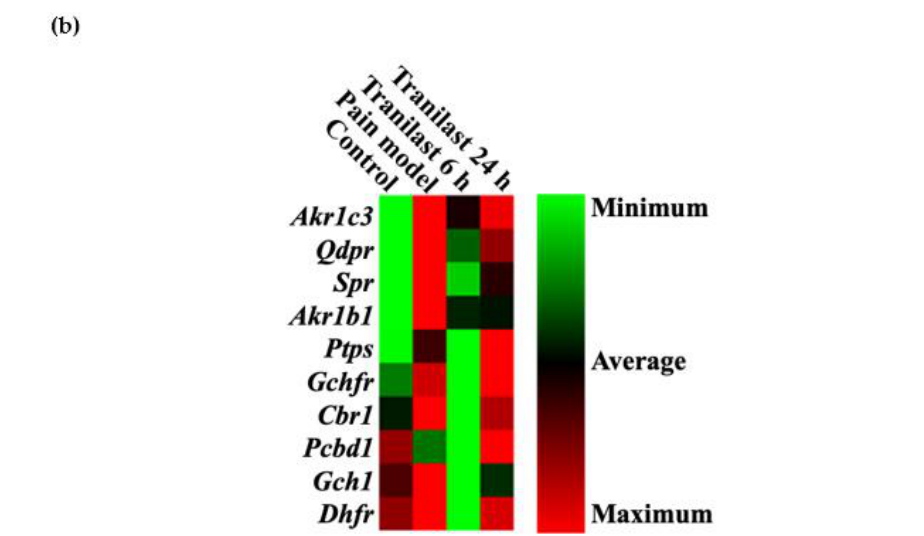
Figure 6. Tetrahydrobiopterin (BH4) synthesis pathway and analysis. ( a ) The three metabolic path- ways involved in BH4 production, the de novo (blue), salvage (yellow), and recycling pathway (green). The synthesis of BH4 begins at the “ de novo ” pathway, starting from guanosine triphosphate (GTP) catalyzed by the following enzymes: GTP cyclohydrolase 1 (GCH1) modulated by the GTP cyclohydrolase 1 feedback regulator (GCHFR), 6-pyruvoyltetrahydropterin synthesis (PTPS), and sepiapterin reductase (SPR). Additionally, the final step can be influenced by two enzymes: aldoketo reductase (AR) and carbonyl reductase (CR). Alternatively, the “salvage pathway” involves SPR